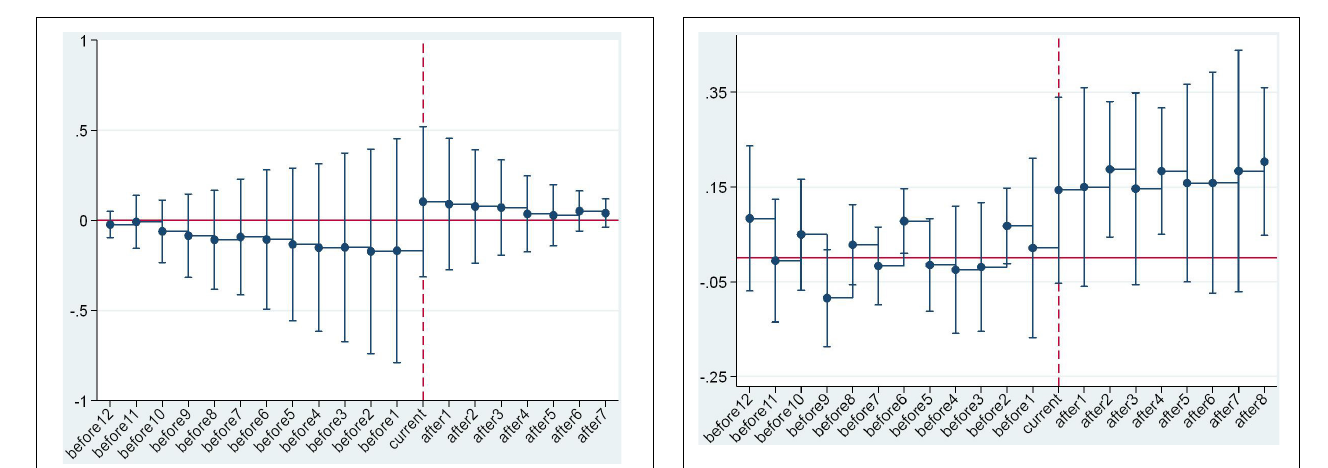
FIGURE 5 | Parallel trend test in the western